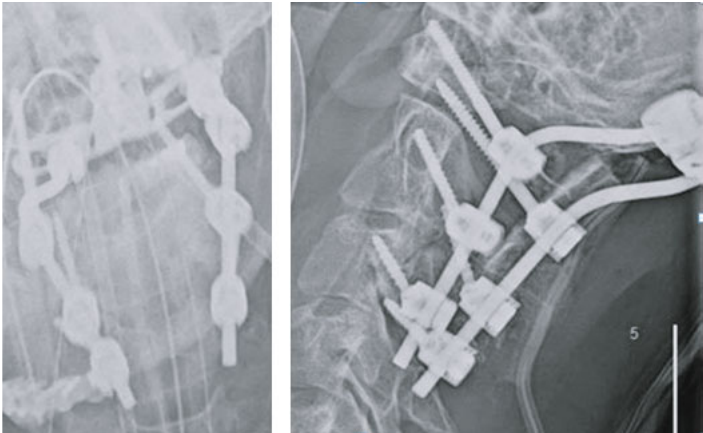
Figure 6: Case 2: postoperative X-ray. Occipito-C6 PSIF.